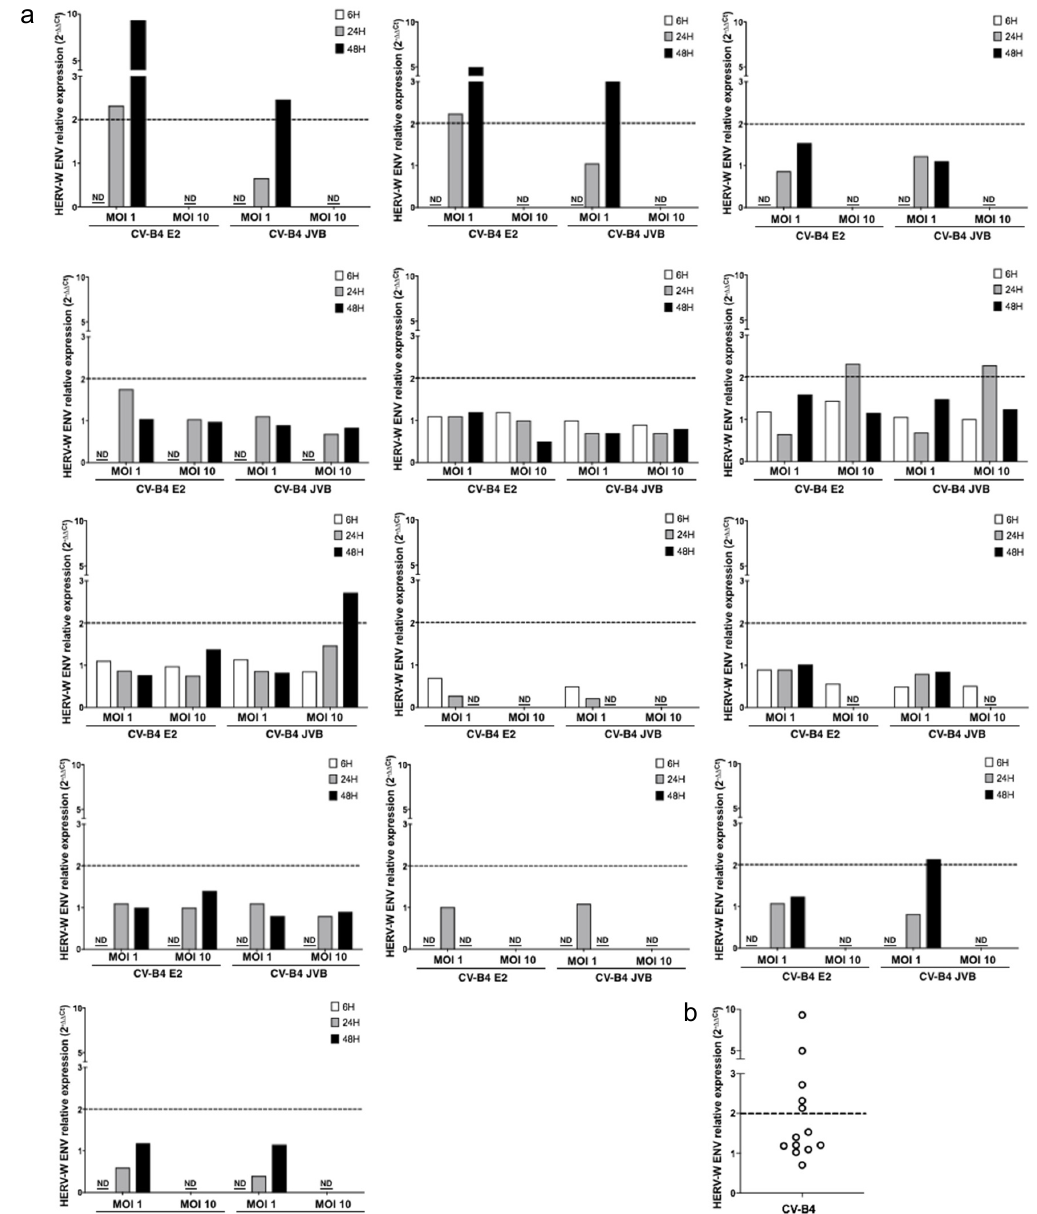
Figure 6. Individual representation of Human Endogenous Retrovirus W Envelope (HERV-W ENV ) mRNA expression in macrophages infected by Coxsackievirus B4 (CV-B4). Macrophages from 13 healthy donors were prepared as previously described in the legend of Figure 5. Total RNA was extracted from the cells 6, 24, and 48 h post infection with TriReagent, and the level of intracellular HERV-W ENV mRNA in each culture was assessed in duplicate using RT-qPCR normalized with beta-actin mRNA expression. Each result is the mean of two or three determinations; furthermore, each RT-PCR datum is the mean of two technical duplicates. The relative expression of HERV-W ENV mRNA in CV-B4 E2-infected cultures compared with that in mock-infected cultures is calculated using the 2 - ∆∆ Ct method. ( a ) The individual relative expression of HERV-W ENV for each culture is shown. ND: not done due to an insufficient number of cells. ( b ) The maximum individual relative expression of HERV-W ENV for each culture is shown. The dashed line represents a relative expression of 2.